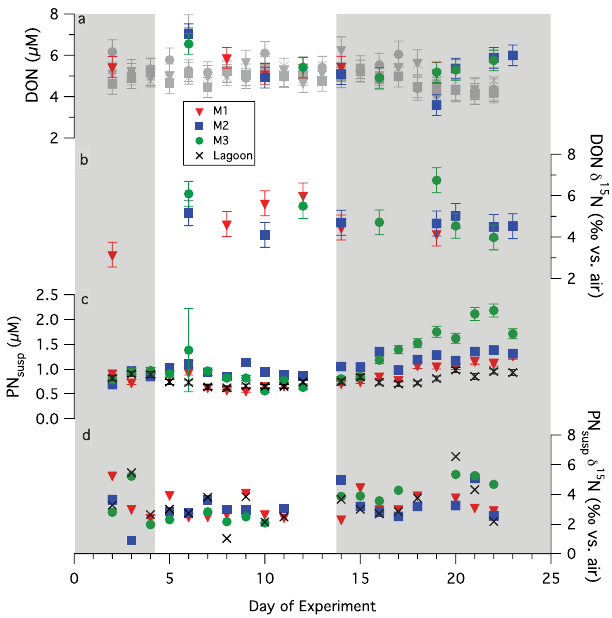
Figure 1. VAHINE water column DON concentration measure- ments from this study in color overlain upon those of Berthelot et al. (2015), in gray (a) , DON δ 15 N (b) , PN susp concentration (c) , and PN susp δ 15 N (d) from within M1 (red filled inverted triangles), M2 (blue filled squares), M3 (green filled circles), and in the la- goon waters outside the mesocosms (“X” symbols). Error bars rep- resent propagated error for DON concentration and DON δ 15 N, and ± 1SD for PN susp concentration. No replicate measurements of PN susp δ 15 N were made, so no error bars are shown. Shaded re- gions indicate P0 (days 1 through 4) and P2 (days 15 through 23), with the unshaded region in between indicating P1 (days 5 through